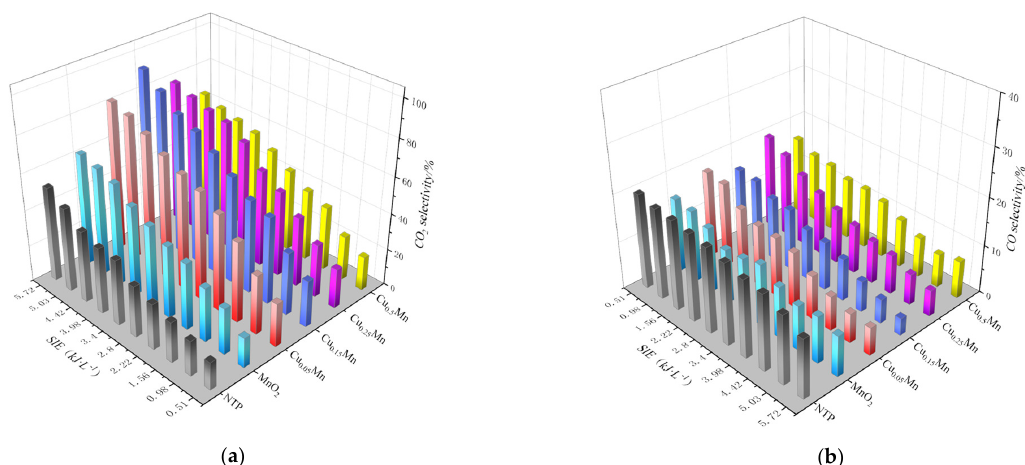
Figure 6. CO X selectivity with different catalysts. ( a ) CO 2 and ( b ) CO.